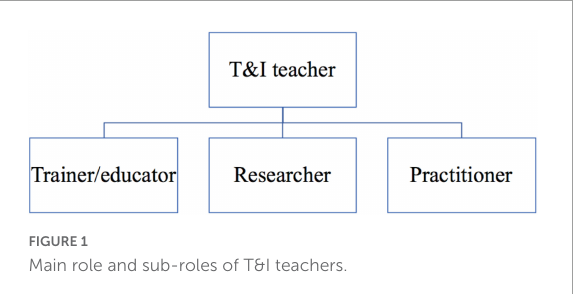
FIGURE1 Main role and sub-roles of T&I